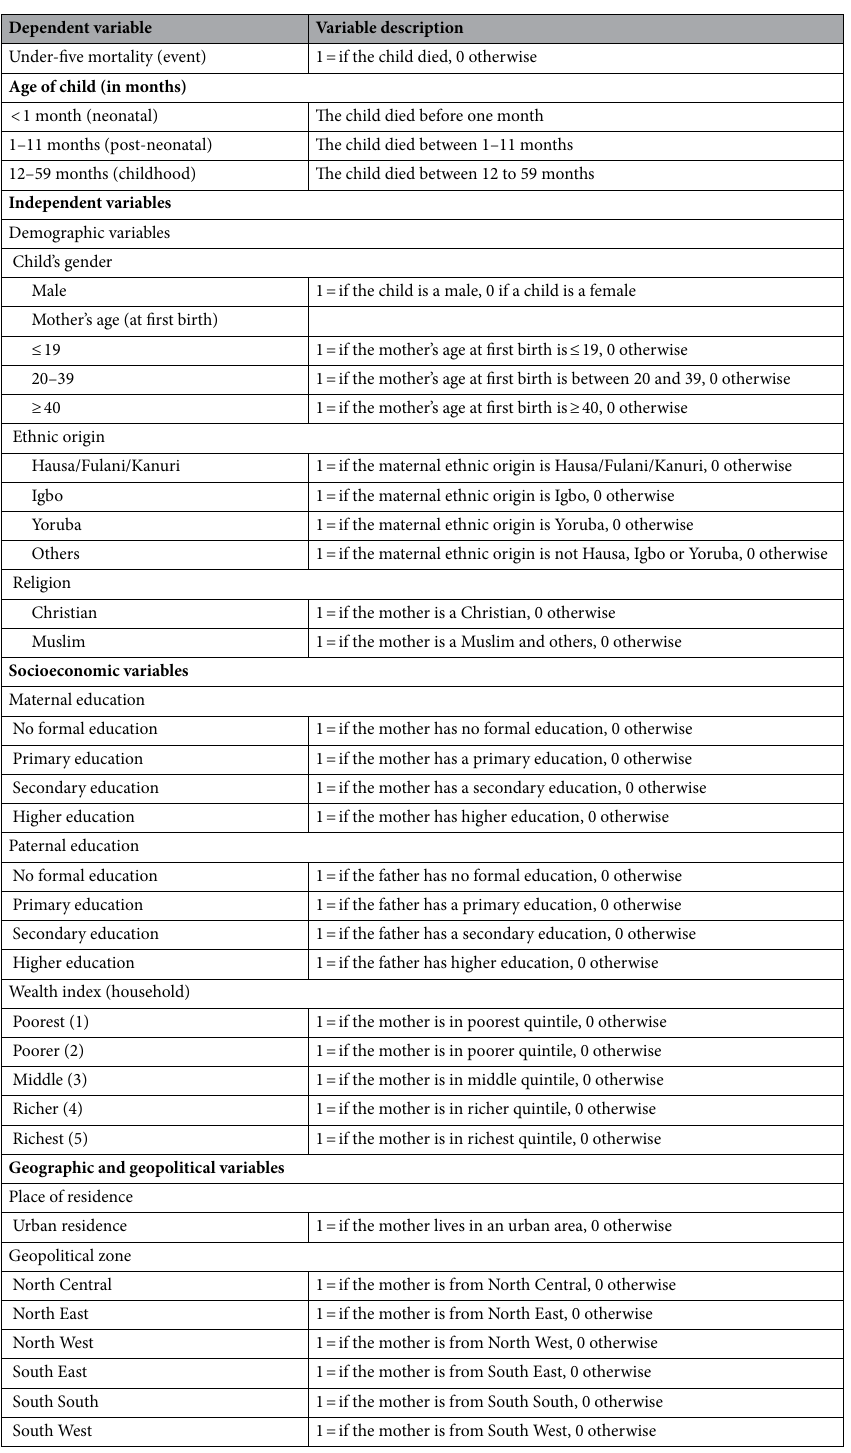
Table 1. Description of variables used in the